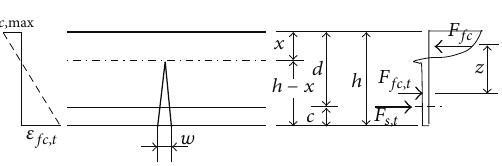
Figure 3: Experimental setup.